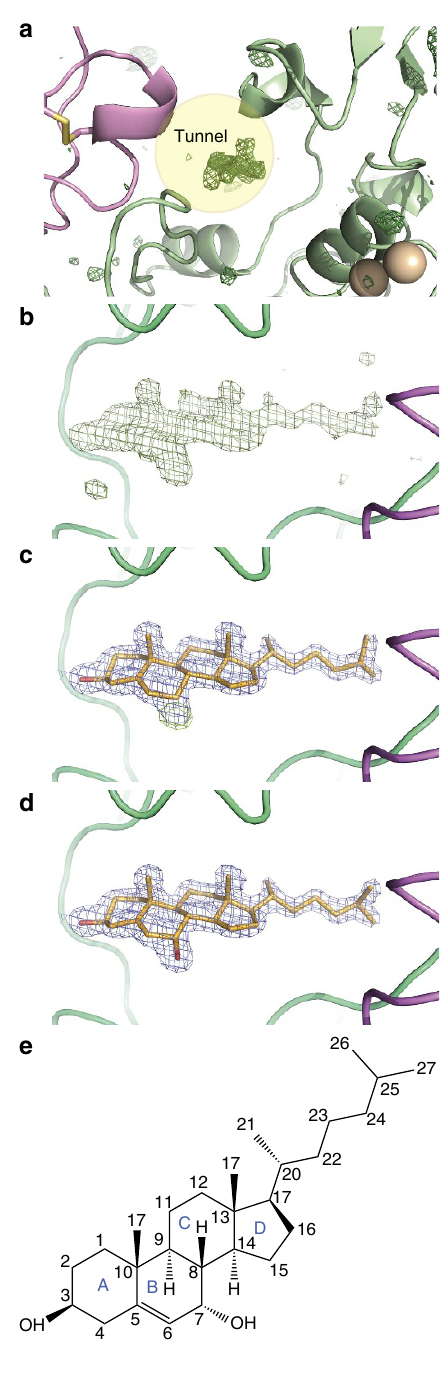
Figure 2 | 7 a -OH steroids are bound in the tunnel of ATX. ( a ) A zoom-in to the model with difference density ( mF o (cid:2) DF c ) shown as a green wireframe model before any ligand or water placement contoured at 3.5 RMS highlighting the unexplained density in the tunnel. ( b ) The model is rotated about 90 (cid:2) along the vertical display axis to show the same difference density map. ( c ) The model is shown in the same orientation as before after including a sterol molecule in the refinement; the resulting 2mF o (cid:2) DF c map is shown in blue at 1.2 RMS and the difference map in green still indicates a missing atom. ( d ) The electron density maps after full refinement including the 7 a -hydroxycholesterol molecule; all difference density peaks have disappeared. ( e ) The molecular structure of 7 a -hydroxycholesterol showing all atom and ring names.